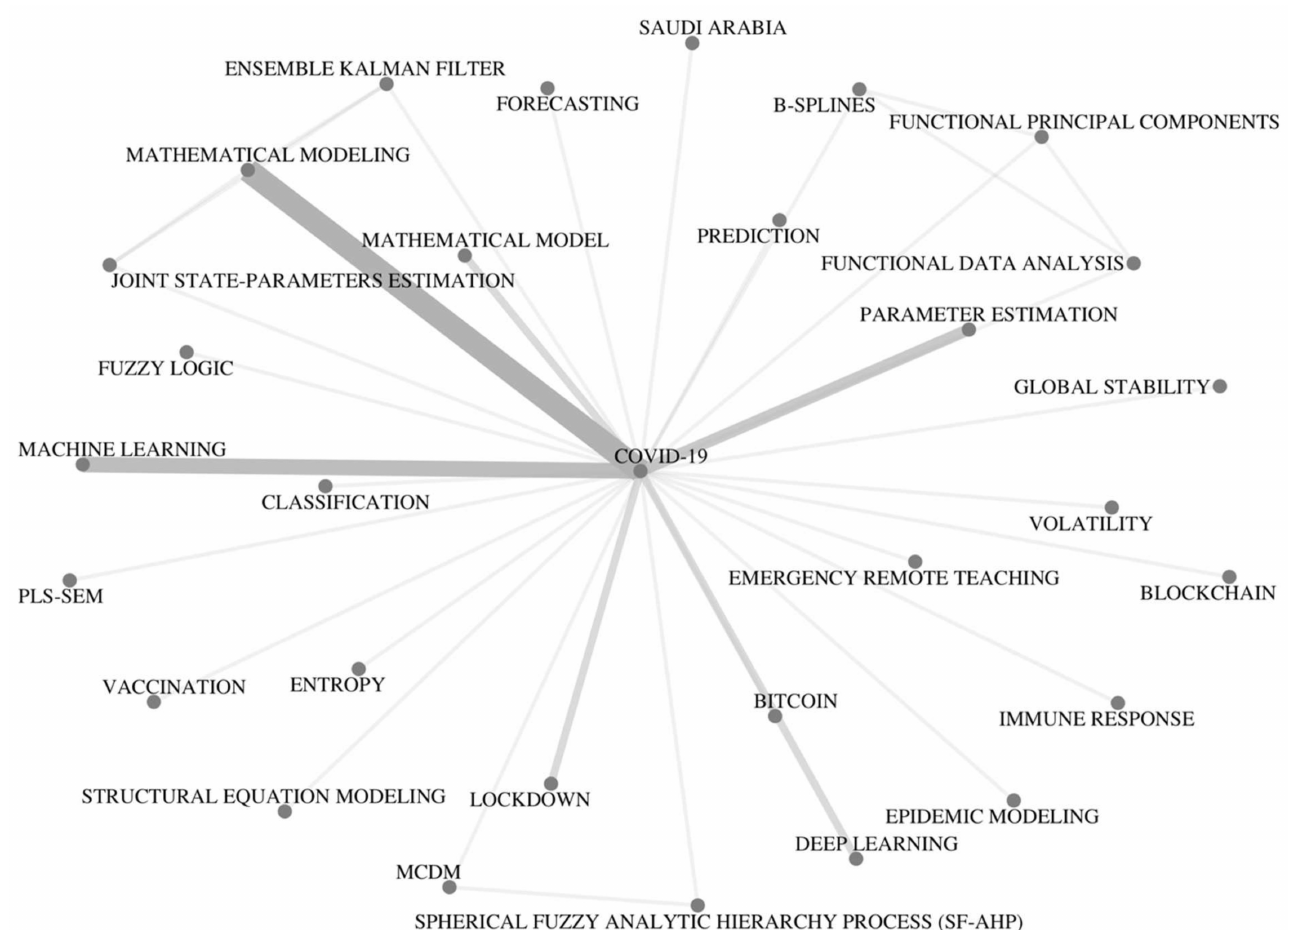
Figure 3. The conceptual network of the term “COVID-19”. To plot this graph, we replaced the keywords COVID, COVID-19 EPIDEMIC, PANDEMIC, SARS-CoV-2, and CORONAVIRUS with COVID-19, and replaced MATHEMATIC MODELLING with MATHEMATIC MODELING for stan- dardization